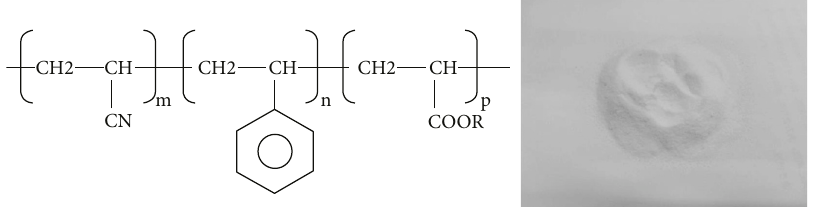
Figure 1: Acrylate-styrene-acrylonitrile molecular structure and sample